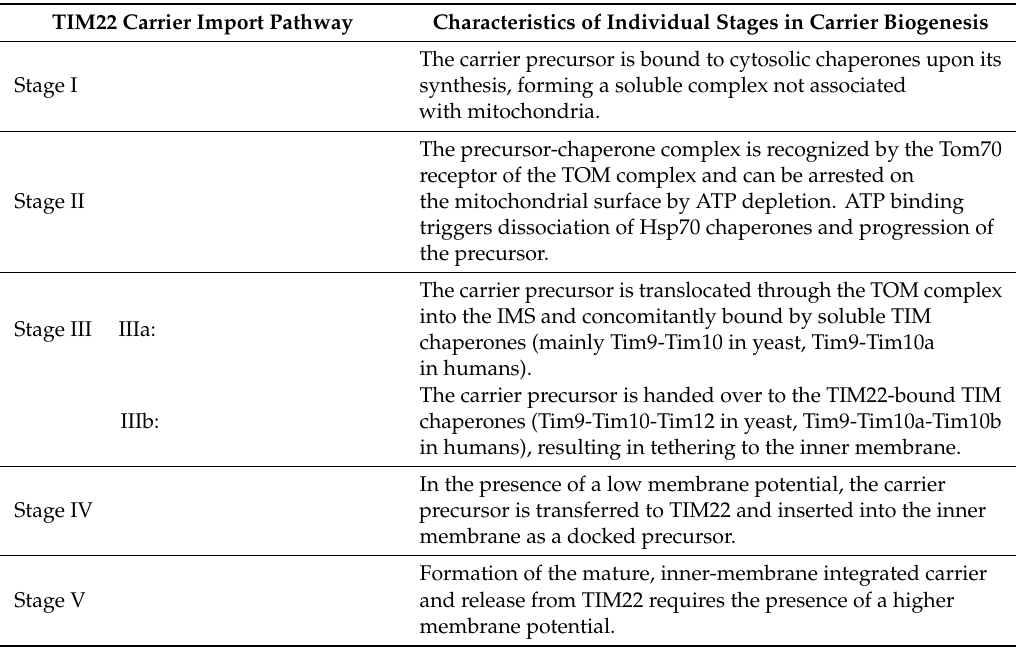
Table 1. Stages of carrier biogenesis via the TIM22 carrier import